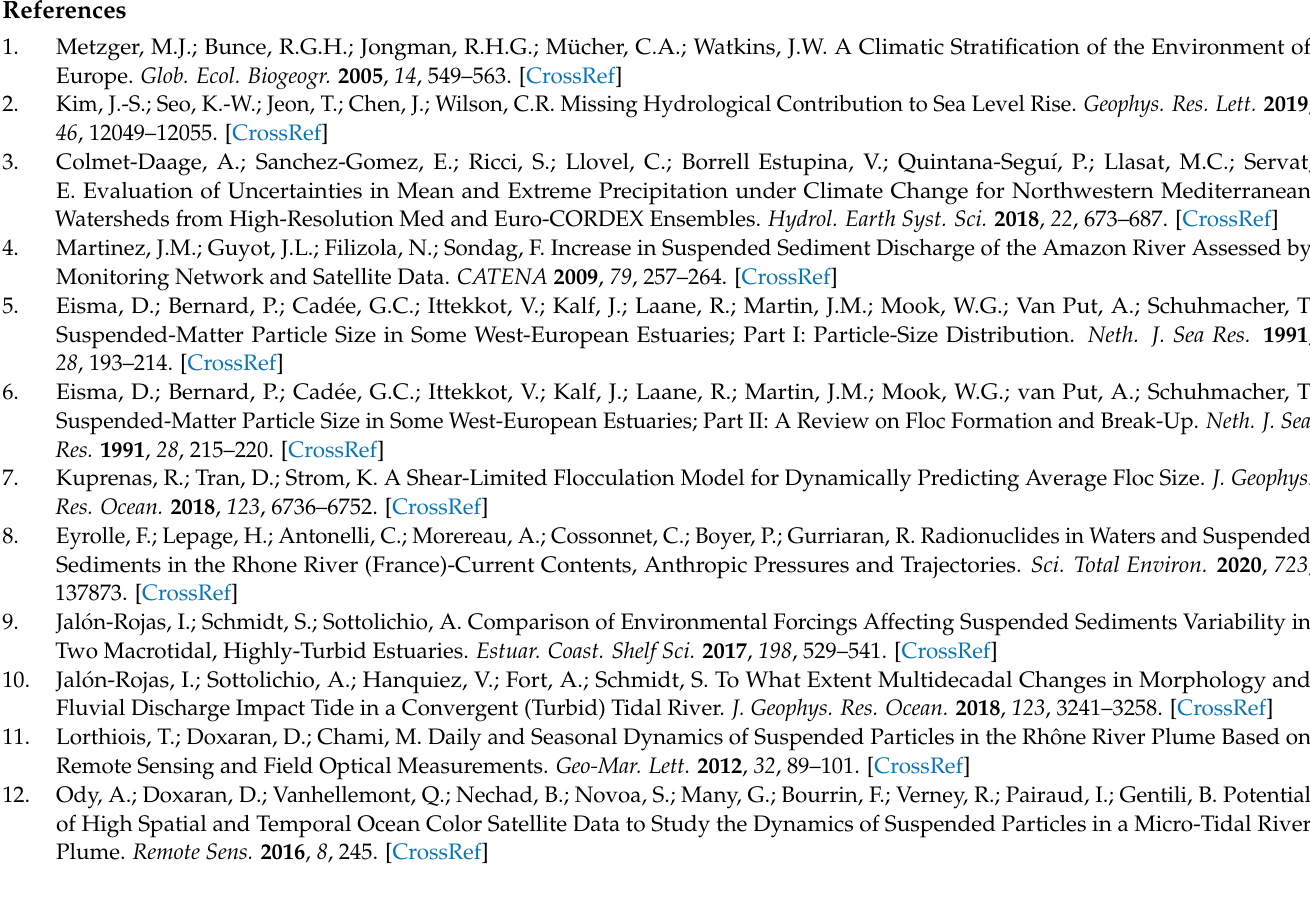
Figure A9. Linear relationships obtained between ρ w values in each equivalent green (green points), red (red points) and NIR (brown points) satellite sensor spectral band. Data are from field campaigns and were weighted by the spectral sensitivity of each sensor band to obtain the equivalent ρ w values. Fitted factors were used to convert ρ w values from one sensor band to another.